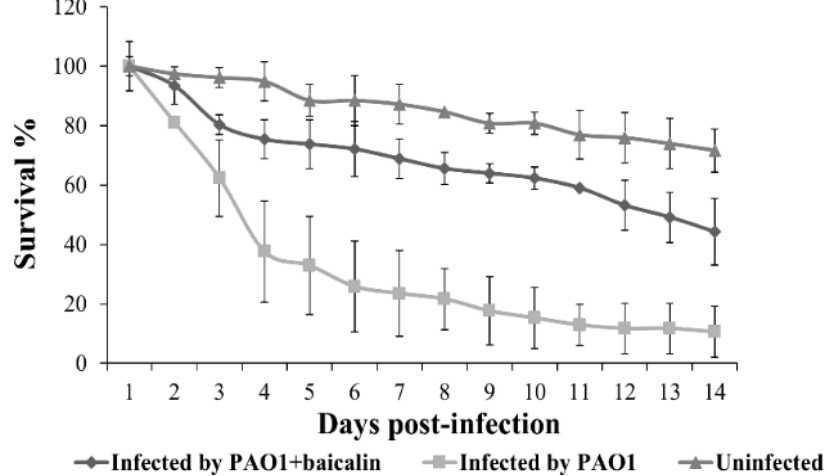
Figure 4. Inhibition of pathogenicity of PAO1 by baicalin in fly infection model. Baicalin was added at 250 µg/mL. Averages of three independent experiments ± standard errors of the means are shown.